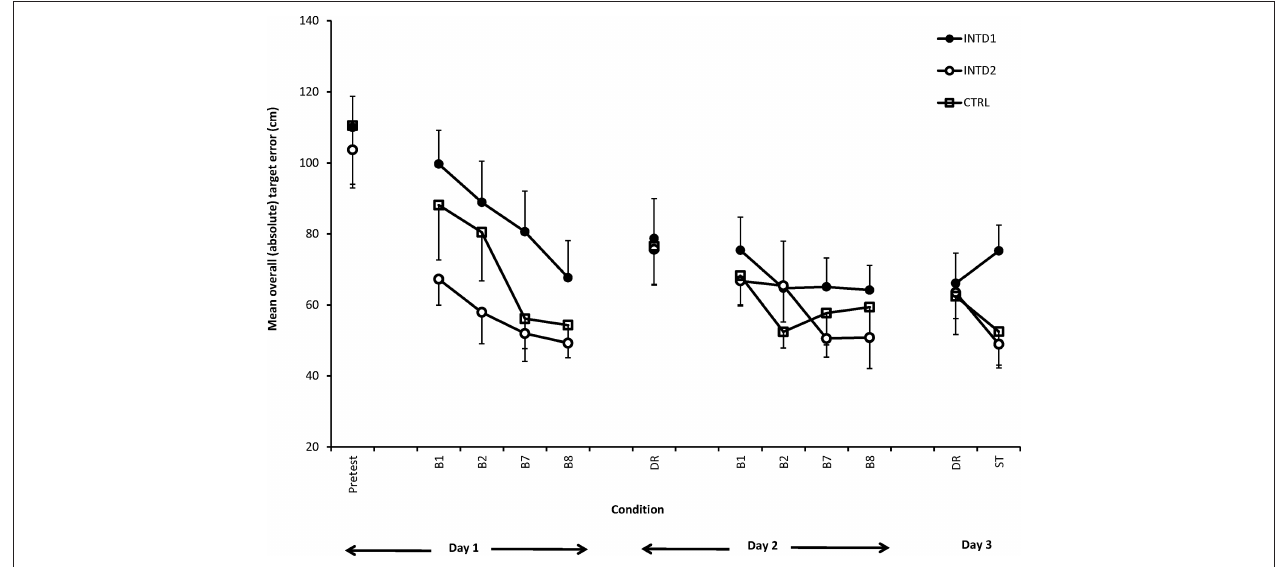
Figure 2 | average overall (absolute) target error (cm) as a function of group, day, condition (pretest, practice, delayed retention [Dr], stress [ST]), and practice block (either the first two practice blocks, B1, B2, or the last two practice blocks B7, B8) in experiment 1. Error bars represent standard error